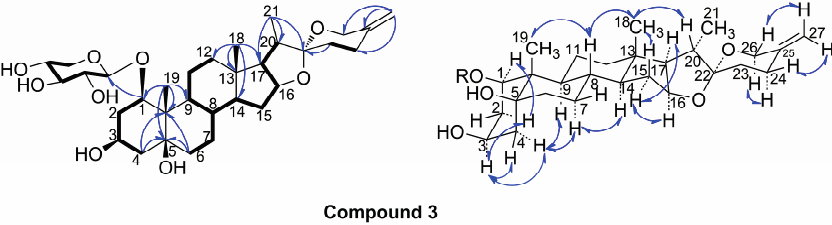
Figure 4. Key HMBC, 1 H- 1 H COSY and NOESY correlations of the compound 3 . Additionally, the known furostanol saponins were identified by comparison of their spectroscopic data with those reported in the literature as tupisteroide B ( 4 ) [15] and 5 β -furost- Δ 25(27) -en- 1 β ,2 β ,3 β ,4 β ,5 β ,7 α ,22 ξ ,26-octaol-6-one-26- O - β - D -glucopyranoside ( 5 )